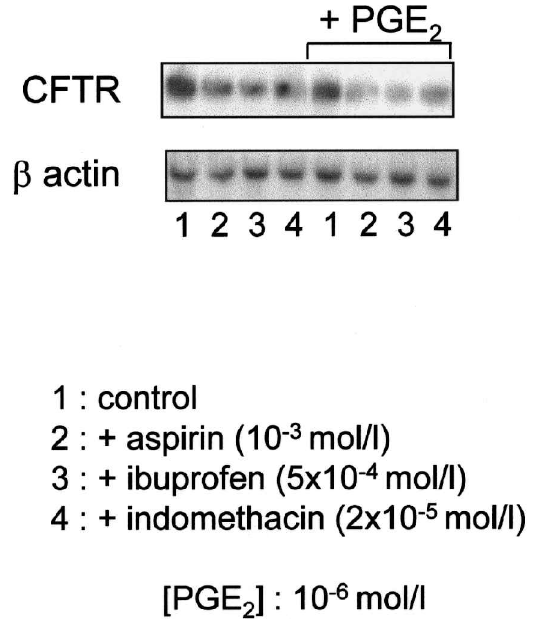
FIG. 6. Absence of the effect of exogenous PGE 2 . Typical Northern blot performed using 15 m g total RNA extracted from cells treated for 24h with aspirin, ibuprofen, and indomethacin in the absence and the presence of exogenous PGE 2 (10 –6 mol/l)